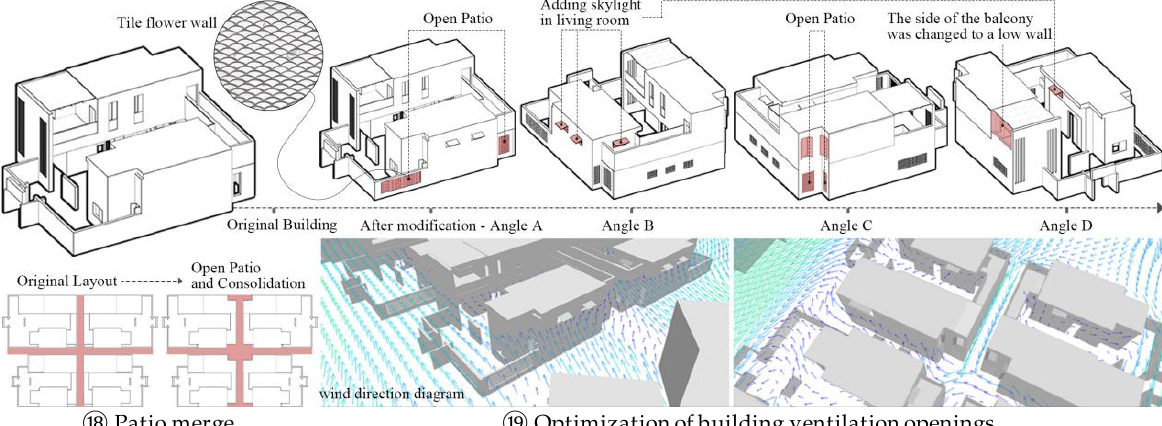
Figure 12. Optimization process of building ventilation openings.